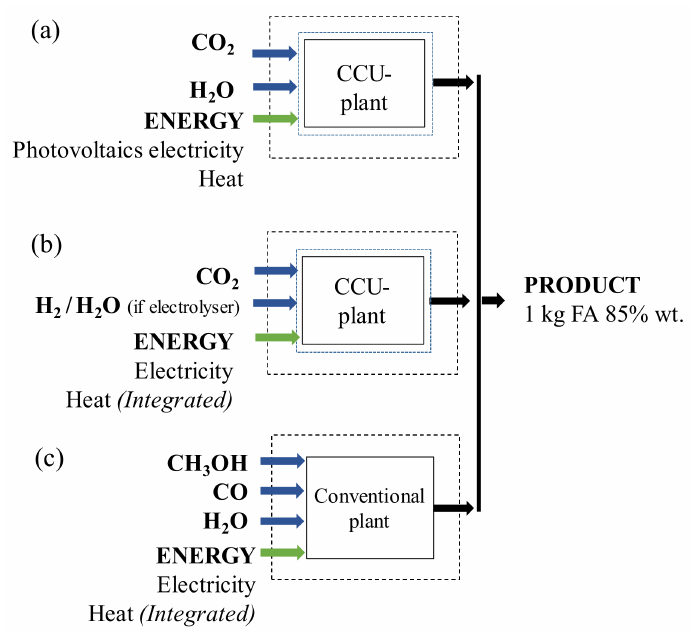
Figure 1. System frameworks: ( a ) alternative A ER (scenarios A1.1, A1.2 and A1.3), ( b ) alternative A JRC , and ( c ) conventional A CONV .